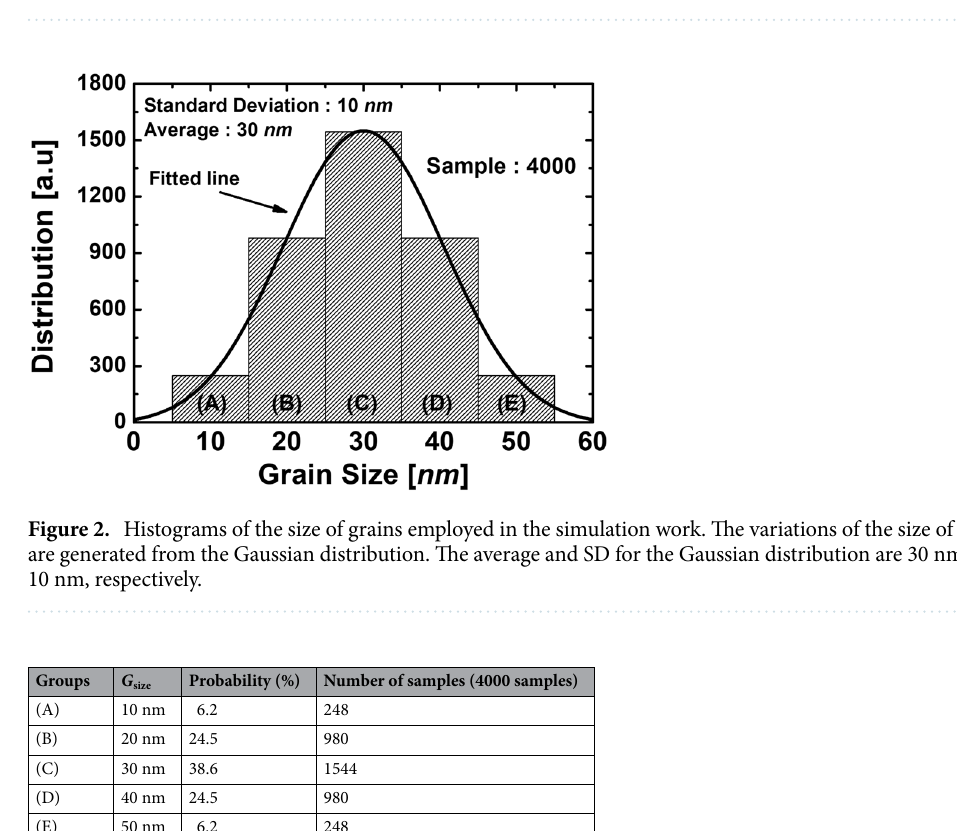
Table 1. Device parameters of the proposed 3-D stacked ADG 1 T-DRAM used for the simulation work.